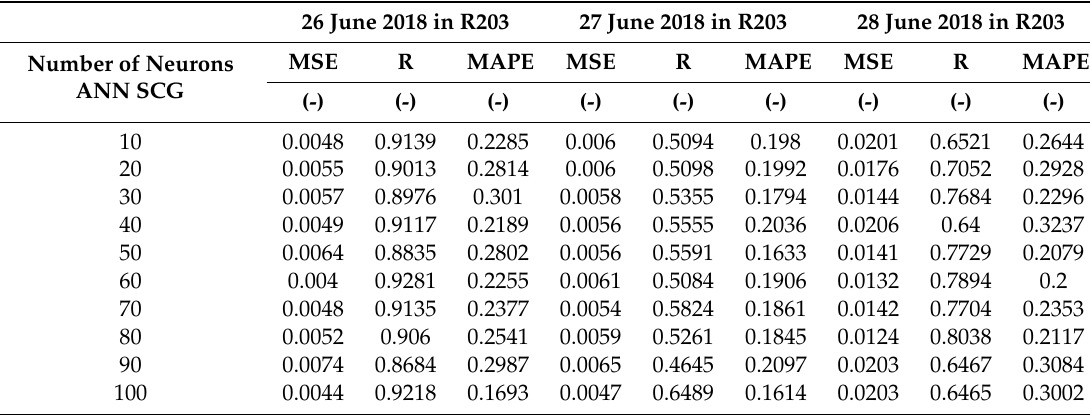
Table 5. Learned ANN SCG from 25 June 2018 in R203 (with T in, rH in and an FBG sensor for PPM) and prediction with cross-validation for 26 June 2018 in R203 (with T in, rH in and an FBG sensor for PPM), 27 June 2018 in R203 (with T in, rH in and an FBG sensor for PPM), 28 June 2018 in R203 (with T in, rH in and an FBG sensor for PPM).